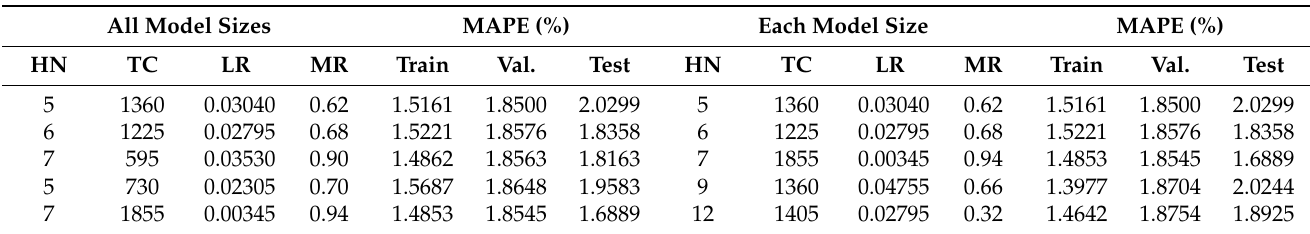
Table 6. Best five settings of ANN of all model sizes and of each model size from sequential grid search.